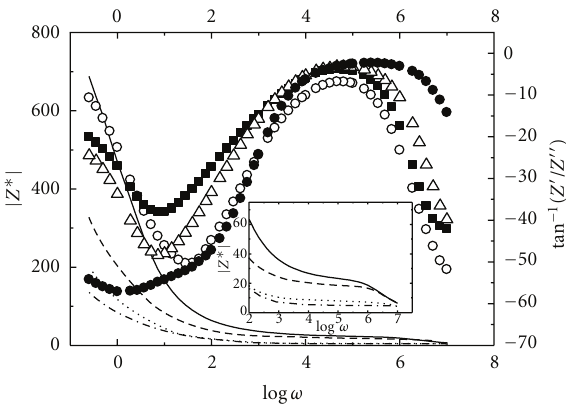
Figure 8: Nyquist plots at 20 ( (cid:7) ), 30 ( (cid:10) ), 50 ( (cid:6) ) y 70 ◦ C ( ∇ ) for the C5FNDIHS membrane in the acid form equilibrated with distilled water. Inset: zoom of the Nyquist plots at high frequencies.